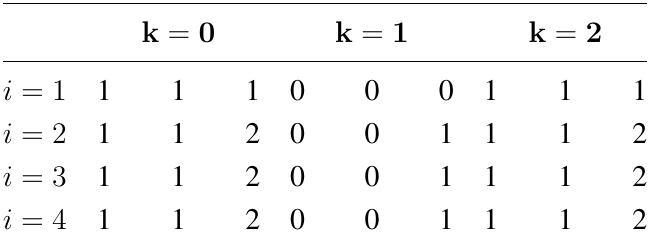
Table 2. L ( i, j, k ) computed by recursive Formula